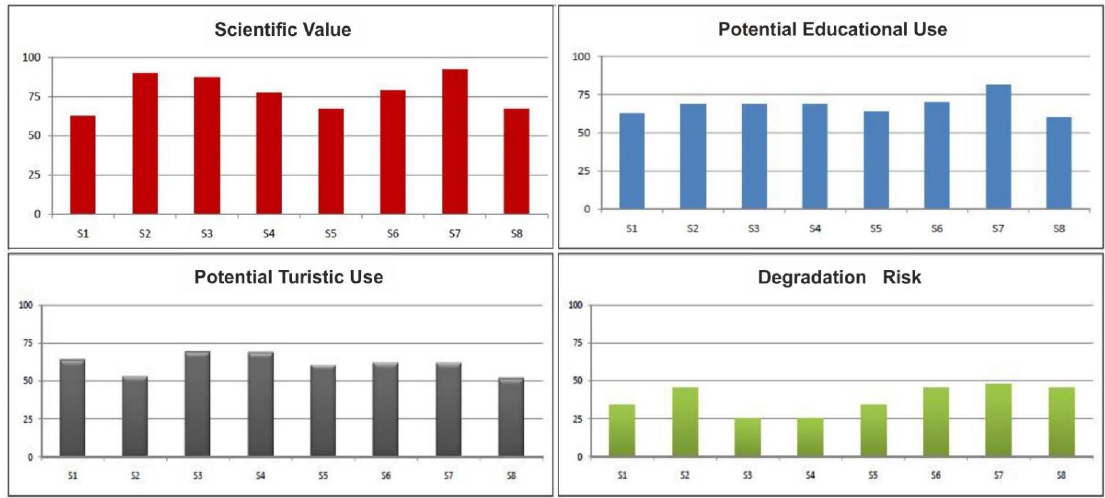
Figure 13. Columns representing the eight sites from the Cenozoic Malaguide Basin from Sierra Espuña for the obtained values of SV, PEU, PTU, and DR.